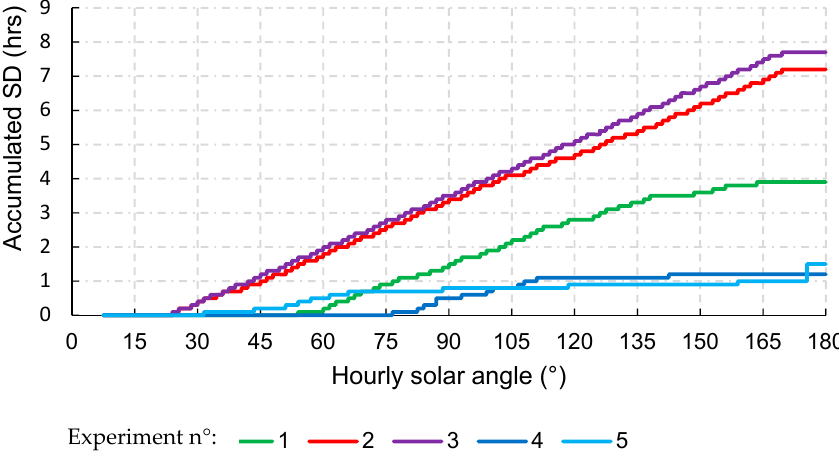
Figure 13. Behavior of daily sunshine readings as a function of the solar hour angle for the device.